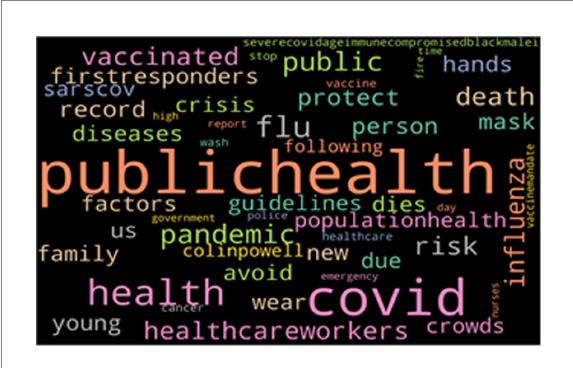
FIGURE 3 The top 50 keywords from negative tweets.